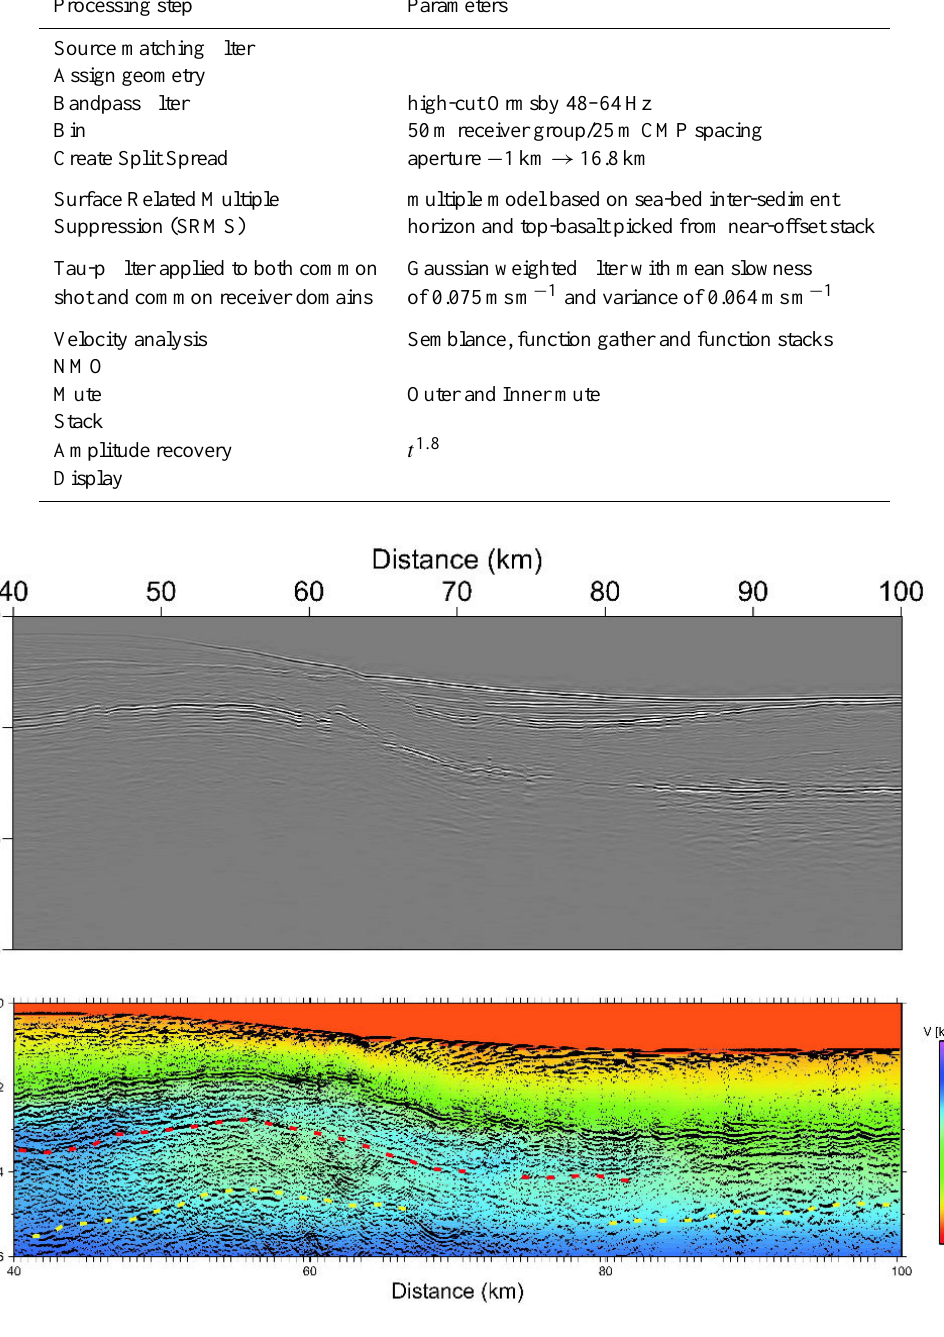
Fig. 5. Top: stacked section from the FLO-96 survey. The top of basalt is clearly delineated. At the beginning of the profile (NW) basalt is shallower (around 1.8s) becoming deeper from kilometer 60 to kilometer 75 where it remains practically flat around 3s until the end of the profile (SE). No coherent subbasalt events can be identified. Bottom: pre-stack depth migration of the same data set. The coloured background stands for the velocity model obtained by means of seismic tomography (Trinks et al., 2005). Dashed lines stand for interpreted base of basalt (red) and top of basement (yellow).